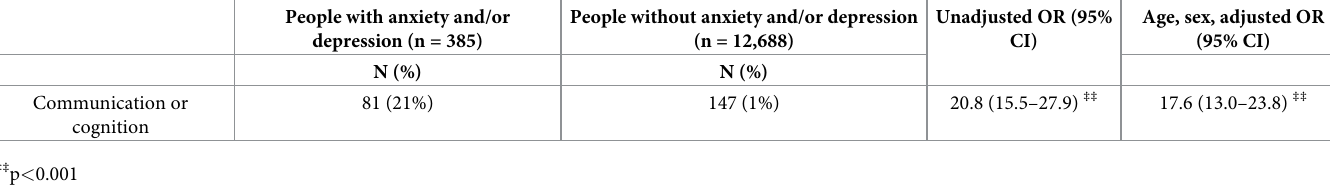
mental health disorders on other health conditions that has been show in previous studies [20]. Cases with anxiety and/or depression had four times the odds of receiving medication for ‘Depression or anxiety’ within the past 12 months compared to cases without (aOR 4.1, 1.9– 9.1). They also had nearly twice the odds of receiving medication for ‘Sleep problems’ within the past 12 months compared to cases without (aOR 1.9, 1.1–3.5). Of 385 cases with anxiety and/or depression, 25 (6%) had received medication for depression or anxiety in the past 12 months.